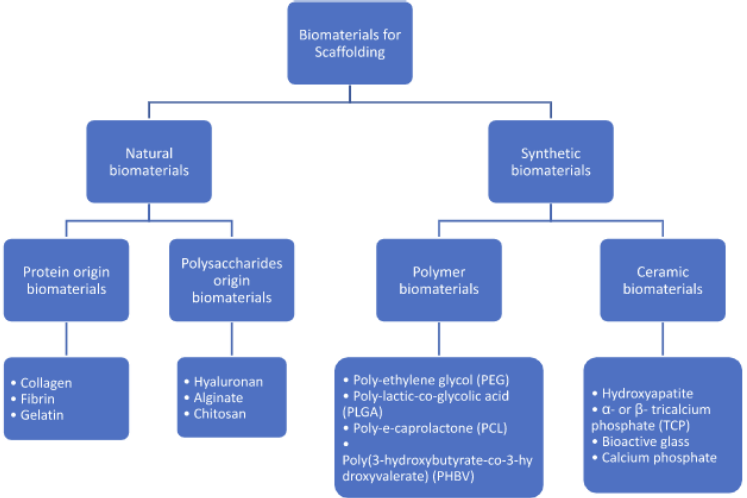
Figure 7. Biomaterials for 3D-printed Scaffolds. Adapted from: Alaribe, F. N. et al., 2016 [156].